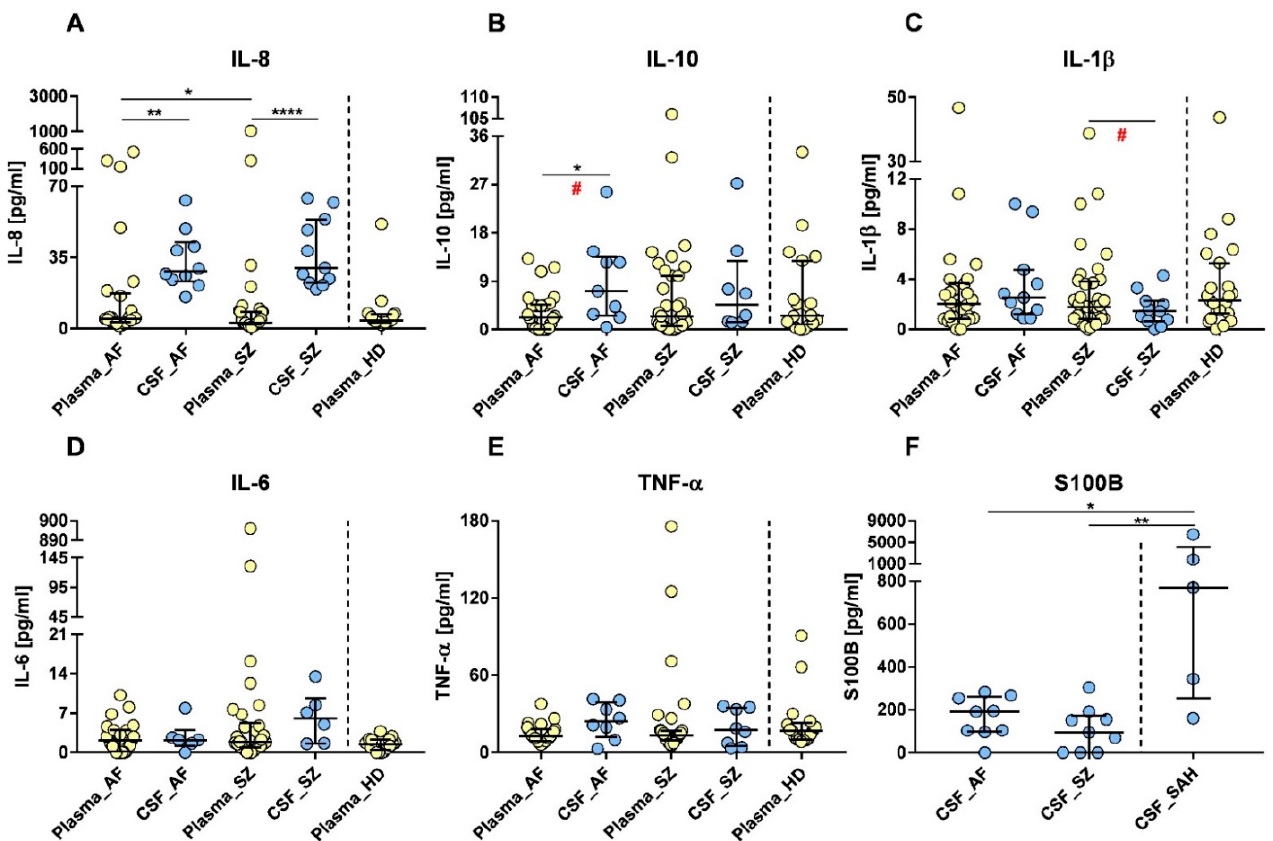
Figure 1. Biomarker concentrations in plasma and cerebrospinal fluid (CSF) of patients with affective (AF), and schizophrenic (SZ) spectrum disorders, and healthy donors (HDs). Concentrations of Interleukins (IL-)-8 ( A ), IL-10 ( B ), IL-1 β ( C ), IL-6 ( D ), tumor necrosis factor α (TNF- α ) ( E ), and calcium-binding protein B (S100B) ( F , CSF only) are shown as scatter plots, with bars indicating the medians, including interquartile ranges. Wilcoxon rank-sum test was performed to analyze differences among groups, with significant differences being marked by * p ≤ 0.05, ** p ≤ 0.01, and **** p ≤ 0.0001. Wilcoxon matched-pairs signed-rank test was performed to analyze differences between patient-matched pairs (plasma vs. CSF), with significant differences being marked by # p ≤ 0.05. AF patients showed elevated IL-8 concentrations compared to the SZ group (median: 4.8 pg/mL vs. 2.95 pg/mL, p = 0.03, Figure 1A). CSF levels of IL-8, compared to the respective plasma concentrations, were systematically elevated in both AF (median: 28.20 pg/mL vs. 4.8 pg/mL, p = 0.002, Figure 1A) and SZ patients (median: 29.90 pg/mL vs. 2.95 pg/mL, p < 0.0001, Figure 1A). For IL-10, a significant difference regarding plasma vs. CSF was observed in the AF group (median: 2.20 pg/mL vs. 7.14 pg/mL, p = 0.02, Figure 1B). IL-1 β in CSF was similar in AF and SZ (median: 2.52 pg/mL vs. 2.03 pg/mL, p = 0.40, Figure 1C). In the SZ group, and when compared for matched samples, IL-1 β was significantly lower in CSF compared to plasma (median: 1.45 pg/mL vs. 1.80 pg/mL, p = 0.02, Figure